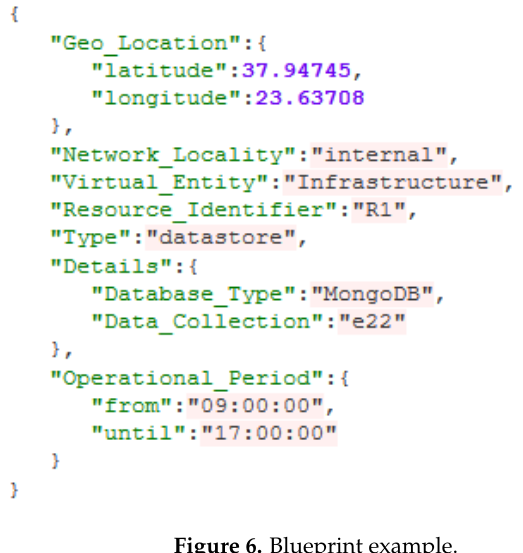
Figure 6. Blueprint